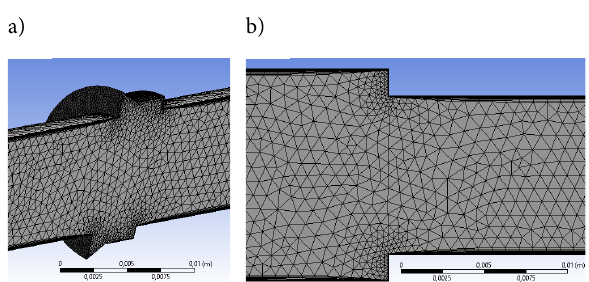
Figure 7. The mesh of the model: a – mesh generation; b – inflating layers with the expansion factor of